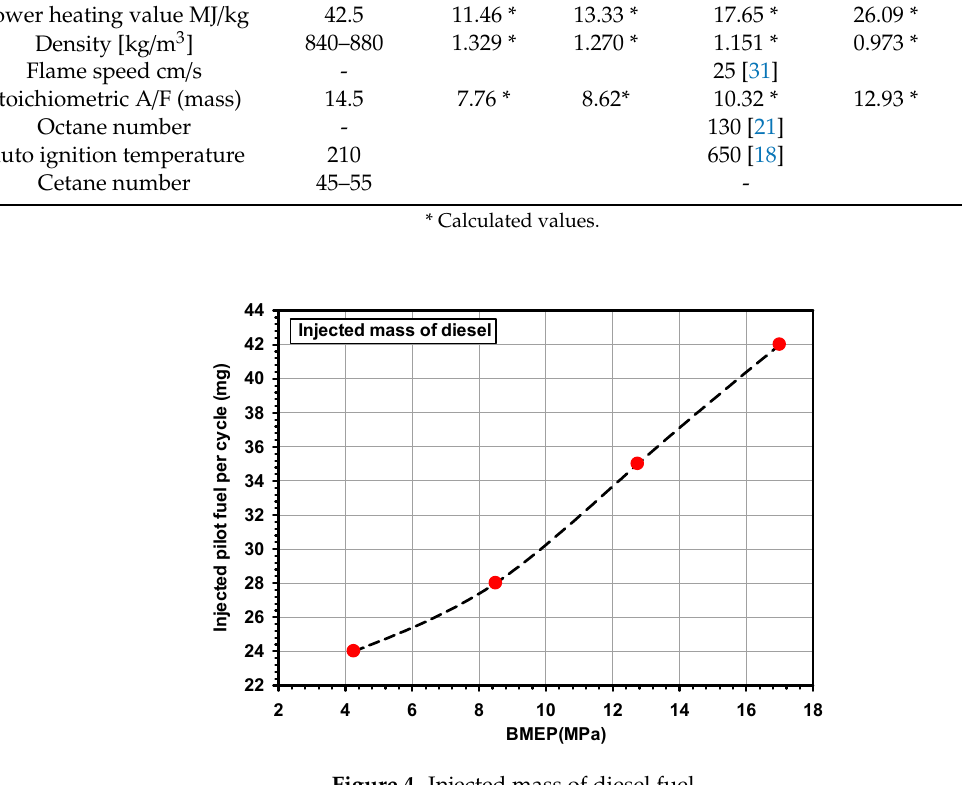
Figure 3. Engine setup.